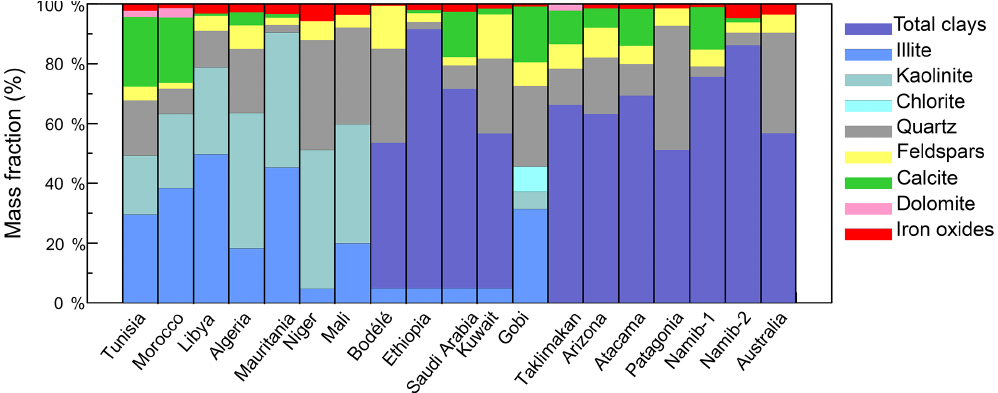
Figure 4. Mineralogy of the 19 generated aerosol samples considered in this study. The mass apportionment between the different clay species (illite, kaolinite, chlorite) is shown for northern African (Tunisia, Morocco, Libya, Mauritania, Niger, Mali, Bodélé) and eastern Asian (Gobi, Taklimakan) aerosols based on compiled literature values of the illite-to-kaolinite (I / K) and chlorite-to-kaolinite (Ch / I) mass ratios (Scheuvens et al., 2013; Formenti et al., 2014). For all other samples only the total clay mass is reported.